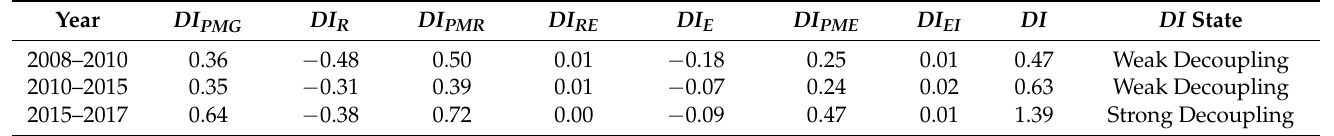
Table 2. The roles of different drivers in decoupling in China from 2008 to 2017.